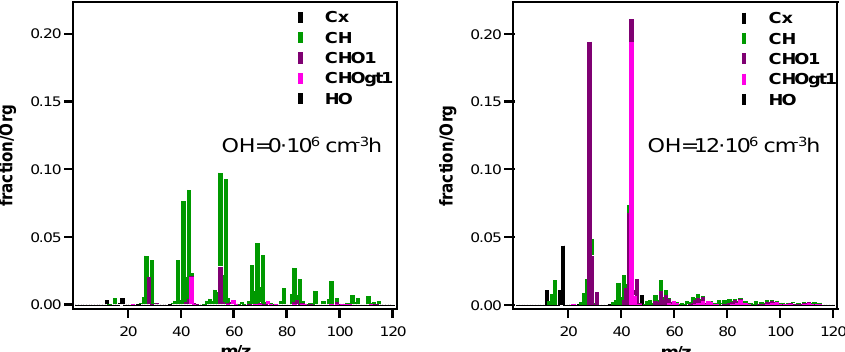
Fig. 9. High-resolution aerosol mass spectra measured at the mobile smog chamber of fresh primary and aged emission at an OH exposure of 12 × 10 6 cm − 3 h from a gasoline light-duty vehicle.